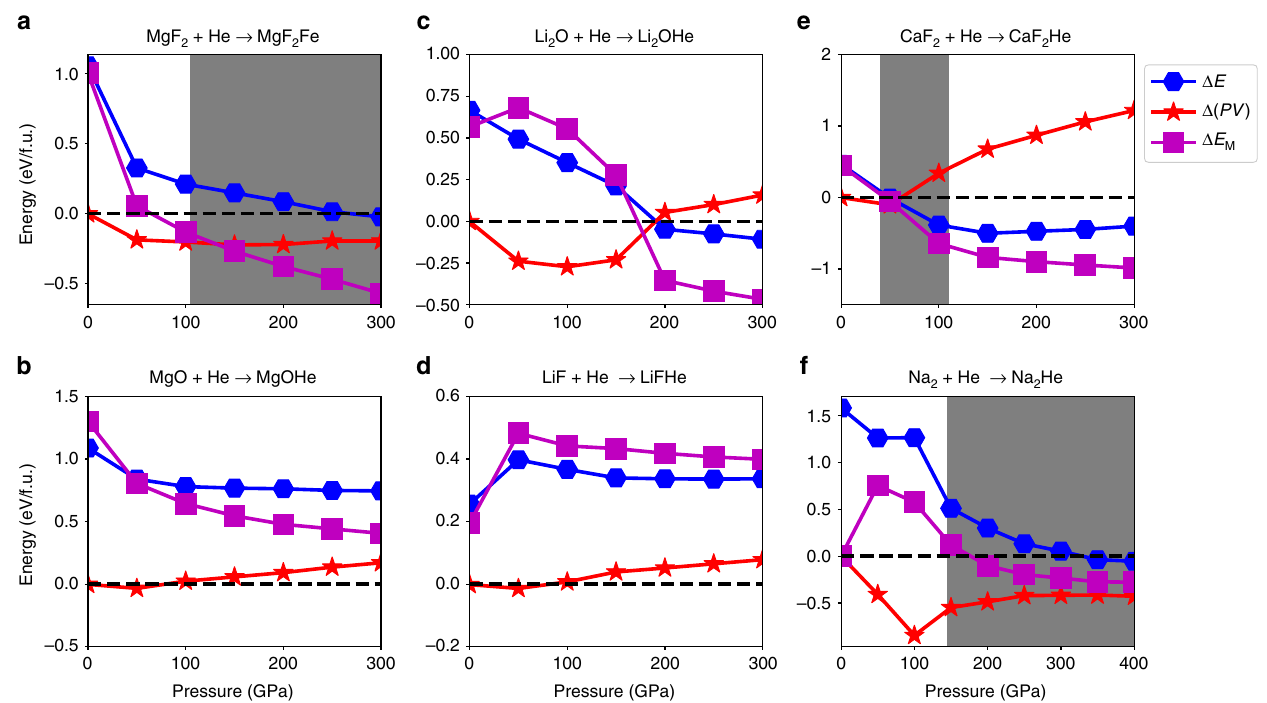
Fig. 5 Relative changes in PV work, internal energy E , and Madelung energy E M for He insertion. a – e The corresponding data of helium inclusion into a MgF 2 , b MgO, c LiF, d Li 2 O, e CaF 2 , and f Na. Relative changes in PV work, internal energy E , and numerically determined Madelung energies E M changes per formula unit are shown with red star, blue hexagonal, and square purple solid lines, respectively